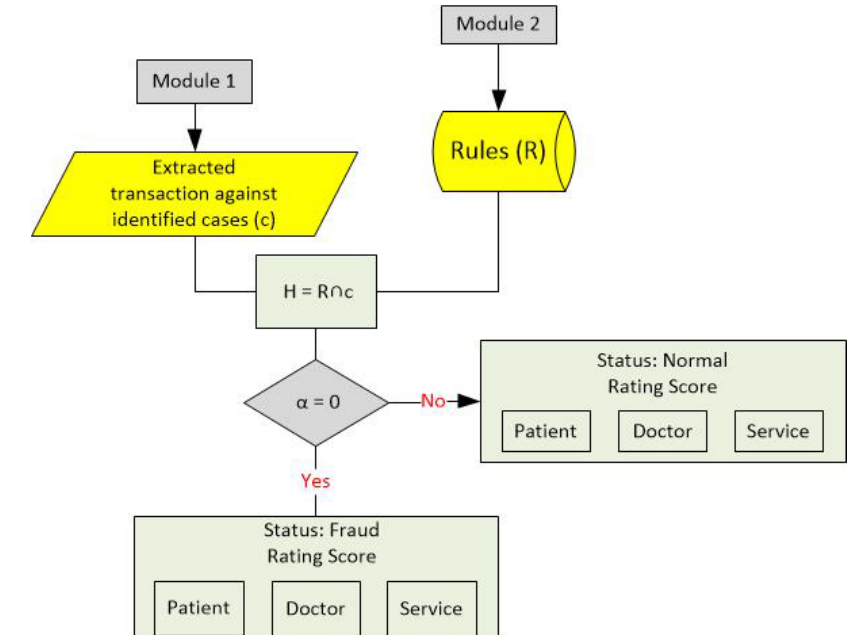
Figure 6. Third phase of Fraud detection model is